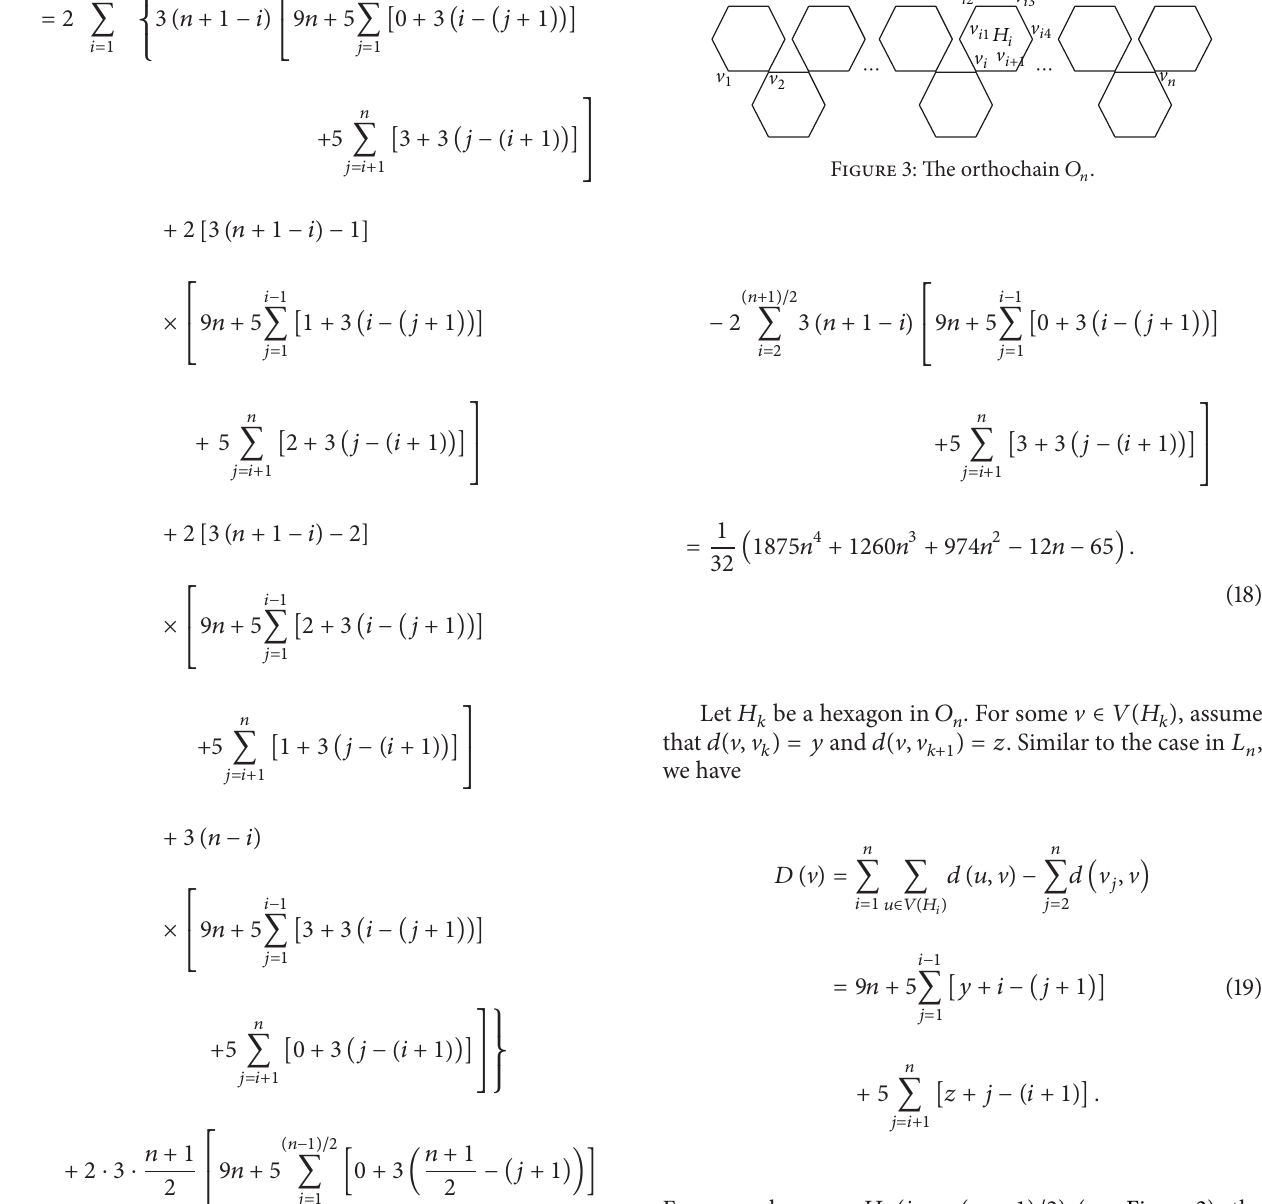
Figure 3: The orthochain 𝑂 𝑛